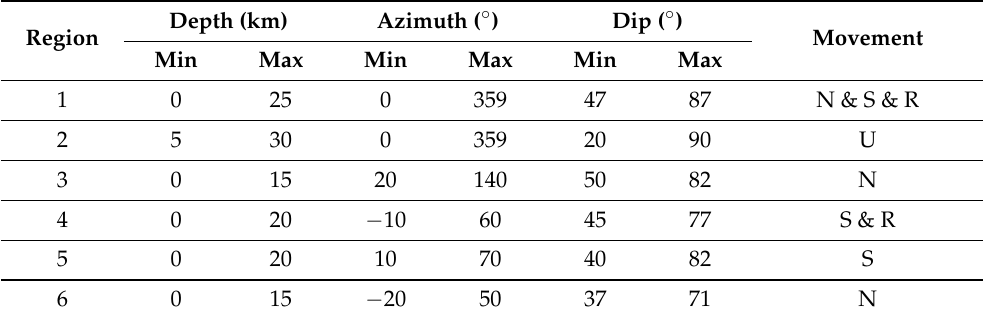
Table A1. Upper and lower bounds of the ranges of values defined for depth, azimuth, dip